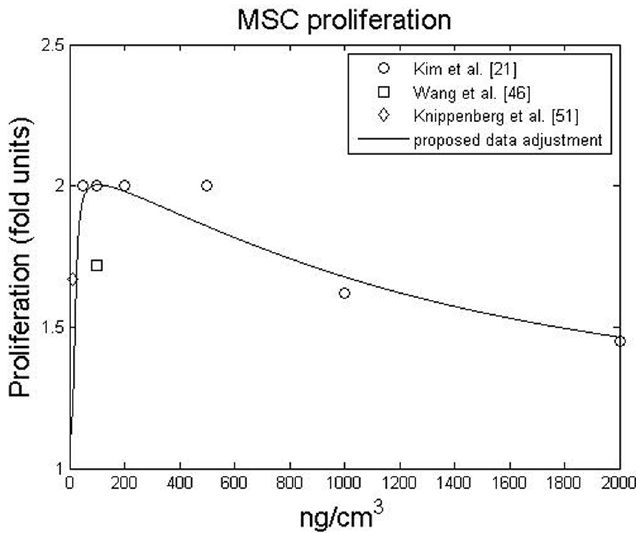
Fig 1. Influence of BMP-2 concentration on MSC proliferation. Proliferation is expressed as a fold increase relative to proliferation without BMP-2